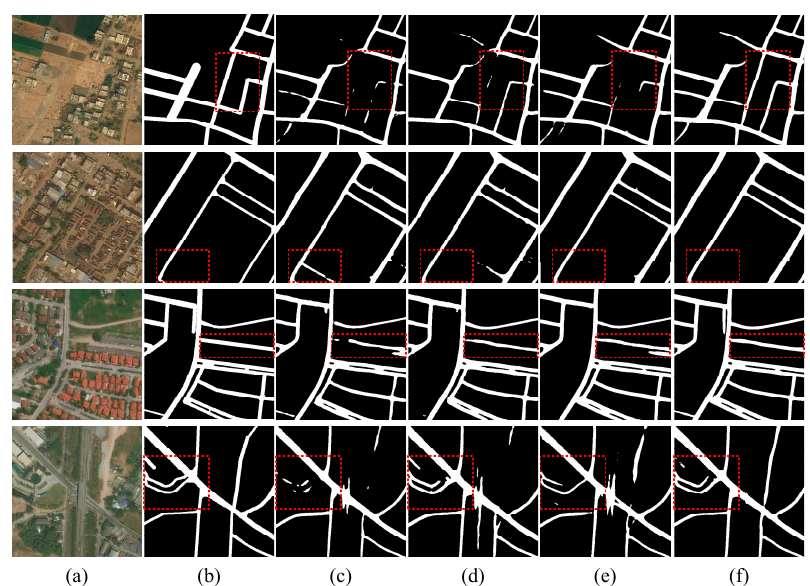
Figure 6. The results of road extraction from the remote sensing imagery with and without MDC and GR. ( a ) Input images; ( b ) ground truth; ( c ) prediction results without MDC and GR; ( d ) prediction results without GR; ( e ) prediction results without MDC; ( f ) prediction results using the GMR-Net model. The red-dashed frame indicates the local details of semantic segmentation.